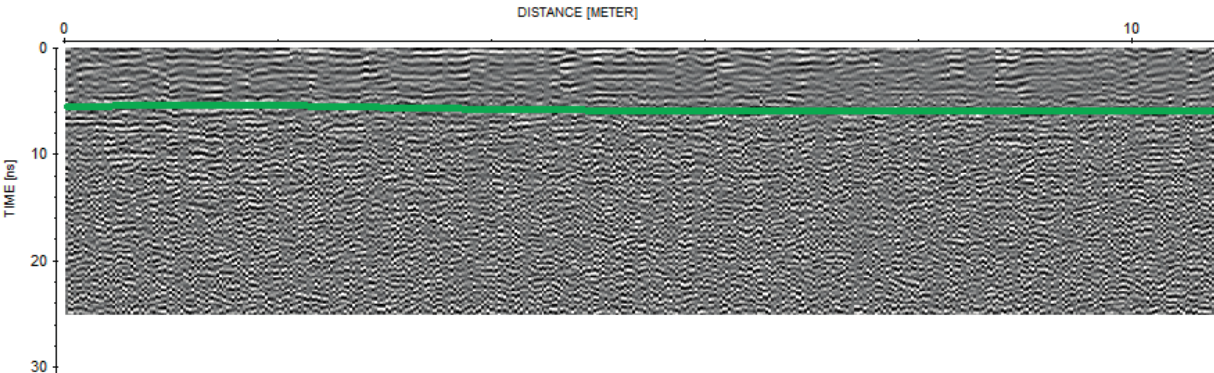
Figure 3. A part of GPR common-offset radar section acquired along a N–S oriented profile (Profile 14) with the 1600 MHz antenna. The depth is represented by time and the green line represented a